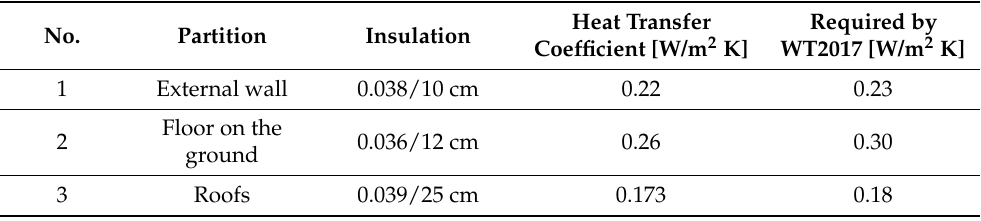
Table 4. Heat transfer coefficients of opaque external partitions assumed for calculations (as per the WT2017 technical